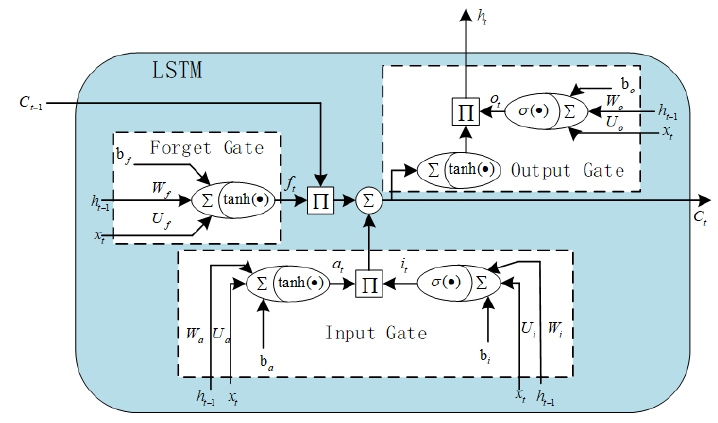
Figure 8. LSTM Memory Cell.